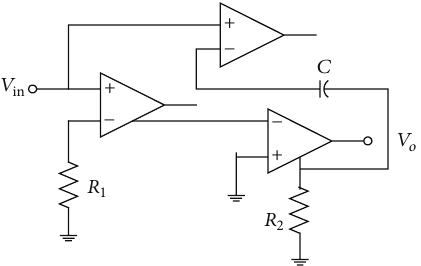
Figure 4: Realization of Figure 3 using AD-844s.